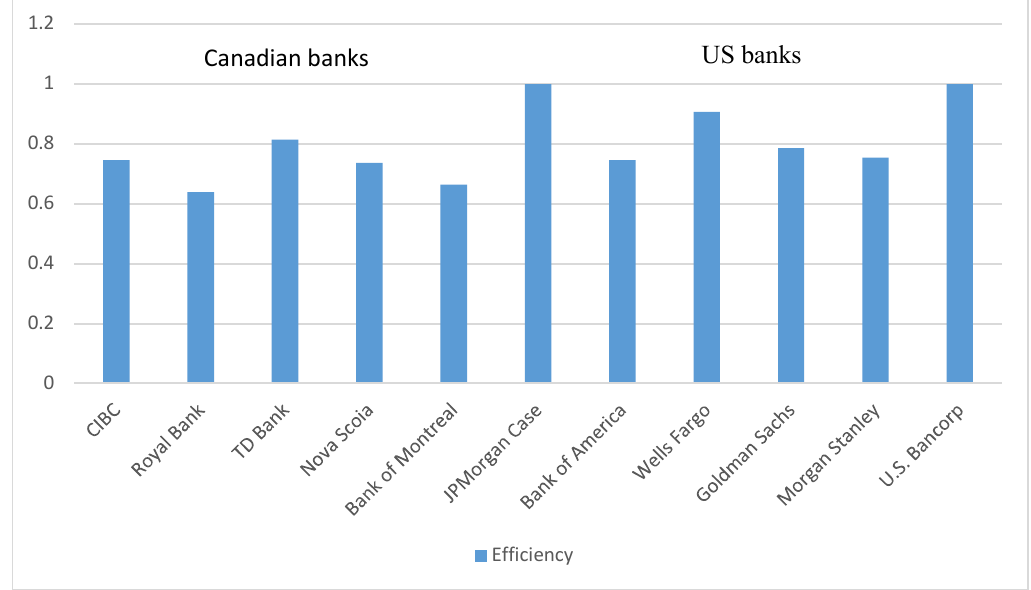
Fig. 2. The results of measuring the relative efficiency of US versus Canadian